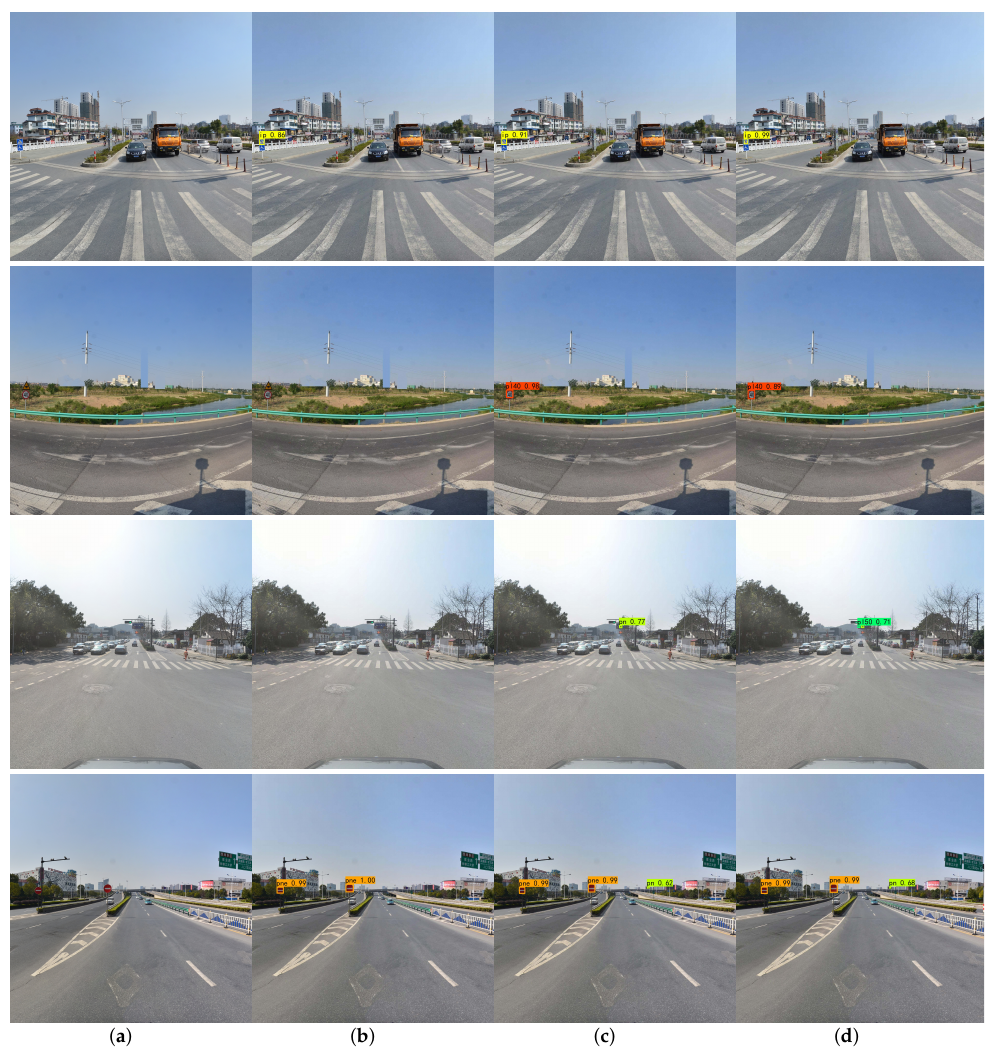
Figure 7. Comparison of traffic sign detection